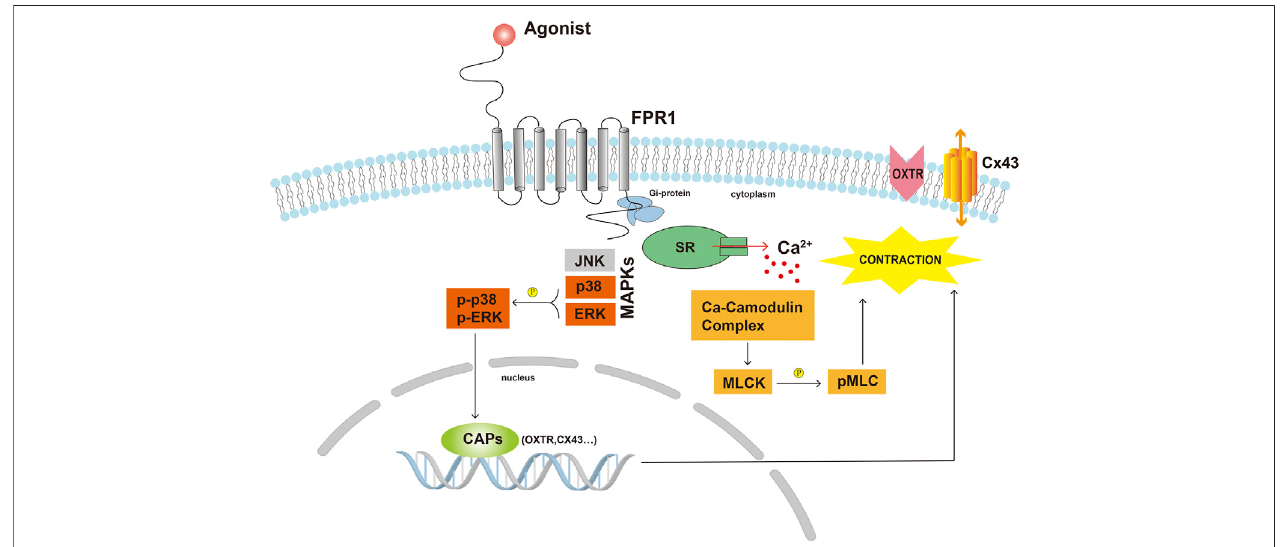
FIGURE 8 | Scheme demonstrating the possible underlying mechanisms of FPR1 activation in myometrial contraction. Abbreviations: CAPs, contraction- associated proteins; Cx43, connexin 43; MLCK, myosin light chain kinase; pMLC, phosphorylated myosin light chain; OXTR, oxytocin receptor; SR, sarcoplasmic